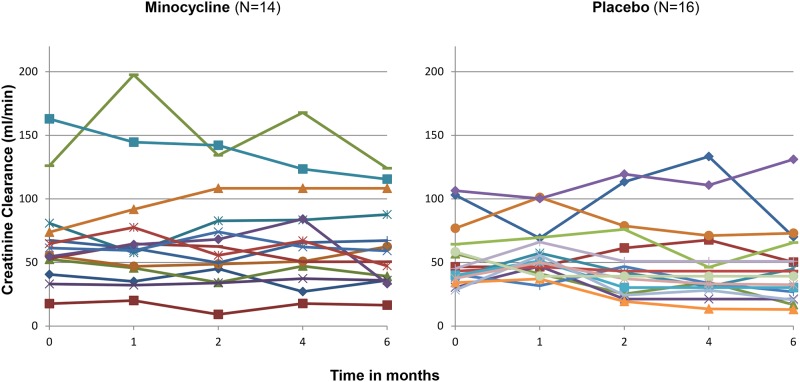
Spaghetti plots of the creatinine clearance measurements of each patient in the study over the course of the trial.